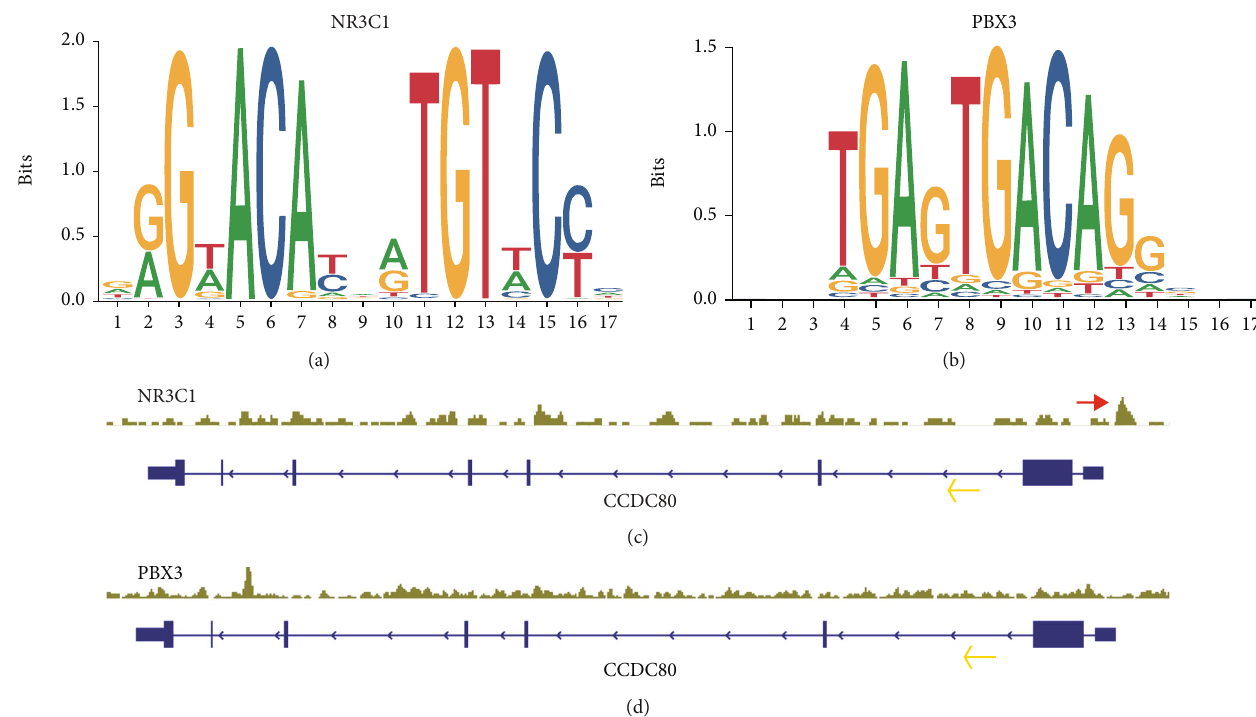
Figure 9: Seqlogos of the motifs of transcription factor NR3C1 (a) and PBX3 (b); ChIP-seq peak (see red arrow) of NR3C1 in the upstream of the transcription start site of CCDC80 (c); and the yellow arrow indicates the transcription direction of CCDC80 ; no ChIP-seq peak of PBX3 in the upstream of the transcription start site of CCDC80